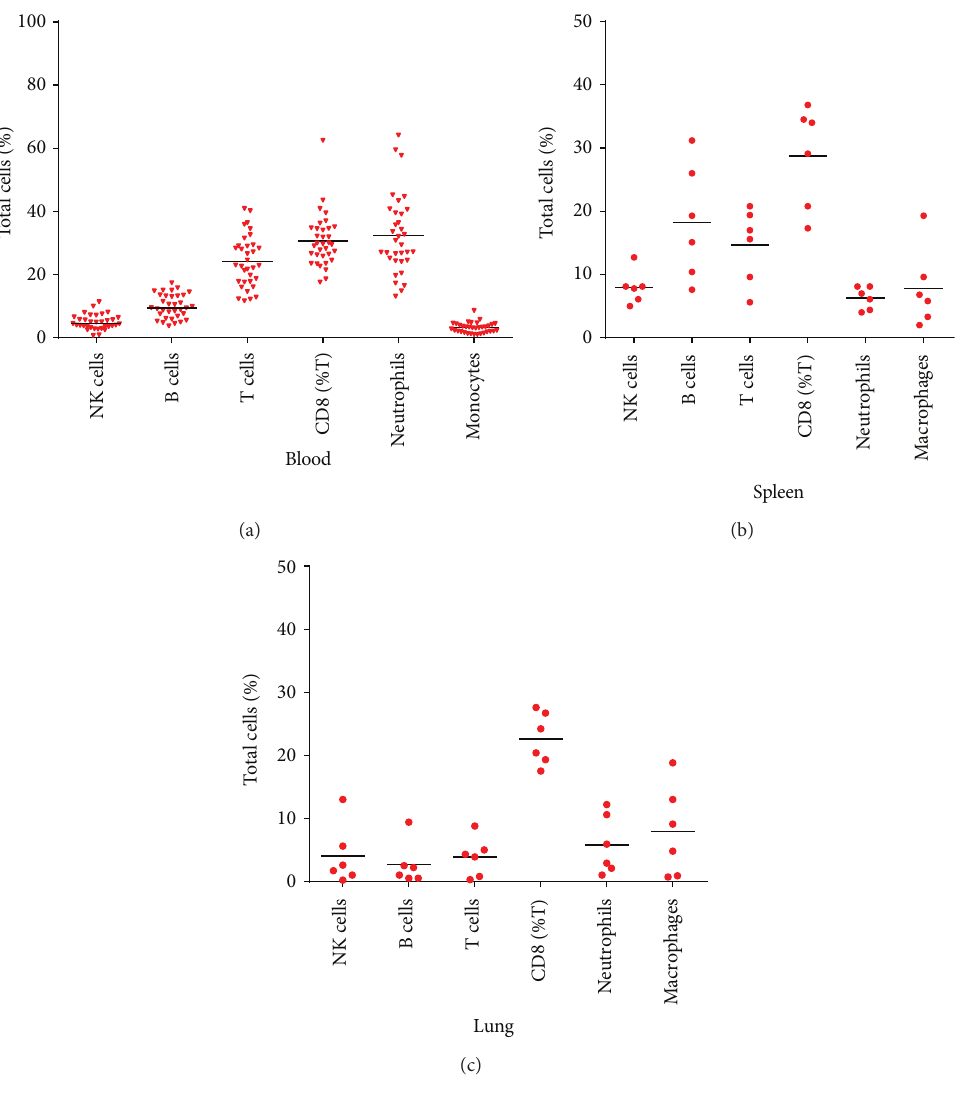
Figure 2: The percentage of the total leucocyte count for various cell types identified in naive marmosets (a) cells in na¨ıve blood, (b) in naive spleens, and (c) in naive lungs. CD8 T cells are expressed as a percentage of CD3+ cells. Bar represents the median value.